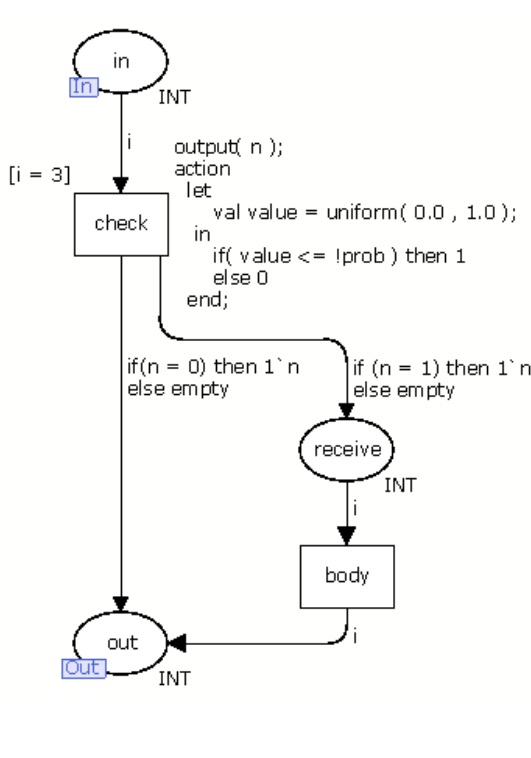
Figure 9. CPN model of the event receive